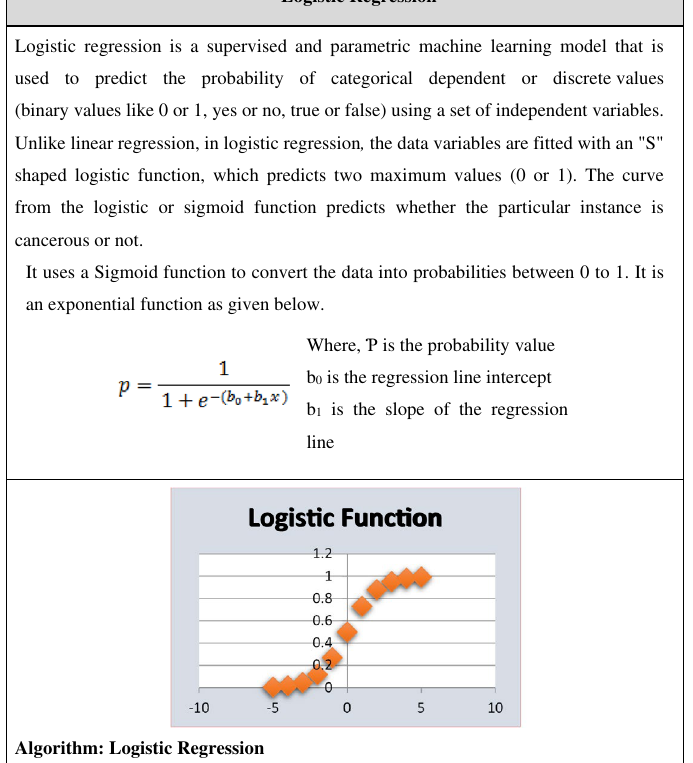
Table 2. Pseudocode for machine learning models. Classification Algorithms Logistic